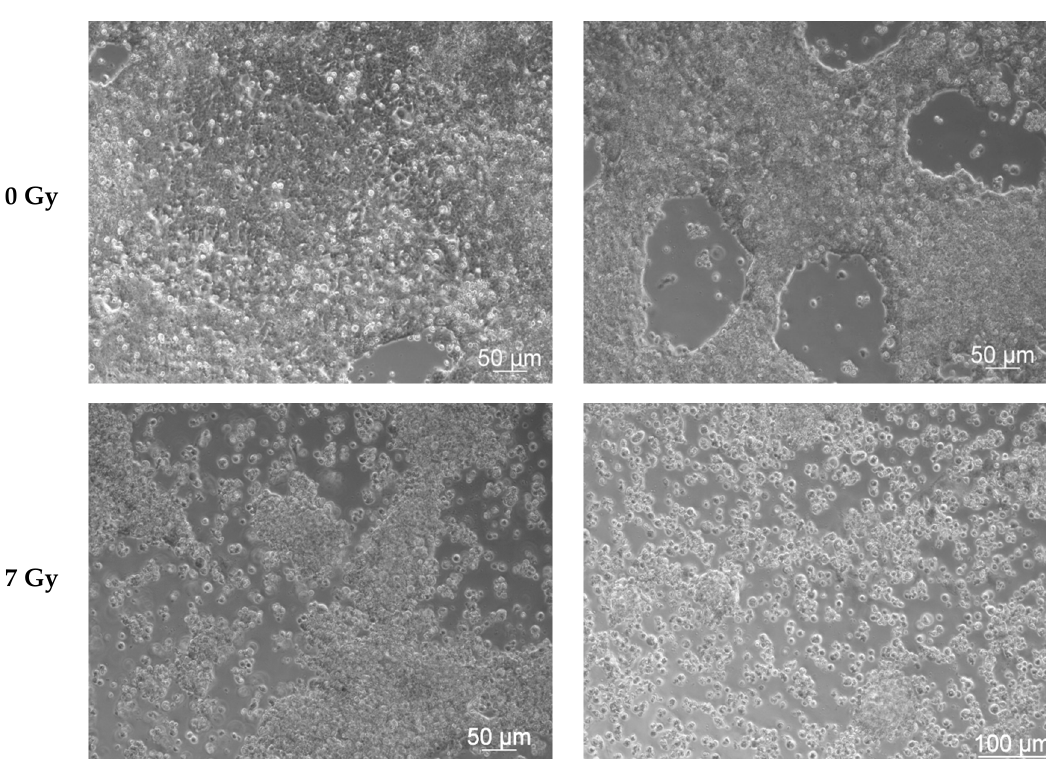
Figure 9. Morphology of mESCs after exposure to X-rays. mESCs cells were cultured in Petri dishes for 24 h and then exposed to X-rays (0 Gy and 7 Gy). The cells were then maintained in the presence and absence of the leukemia inhibitory factor (LIF) for 72 h. The cells were visualized 72 h after irradiation by phase contrast microscopy.